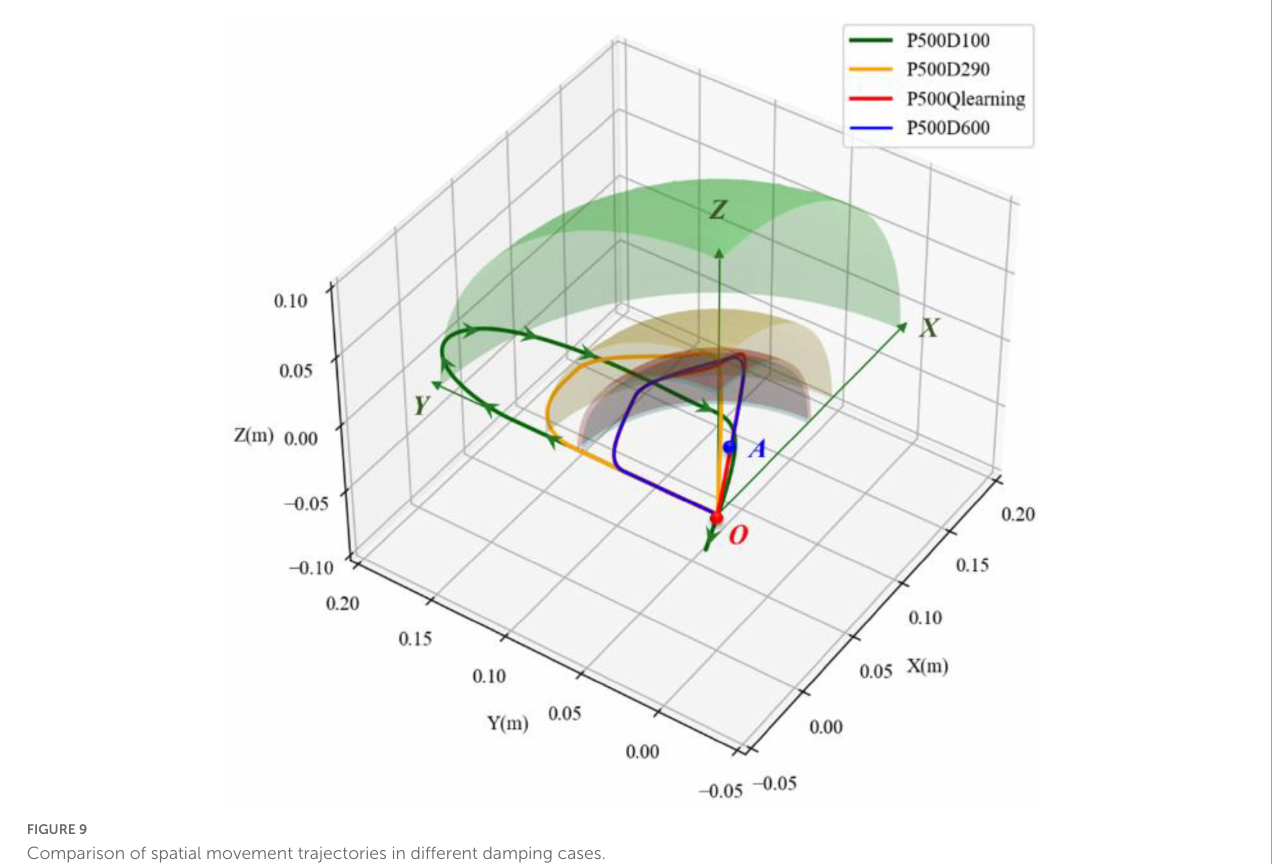
FIGURE9 Comparison of spatial movement trajectories in different damping cases.